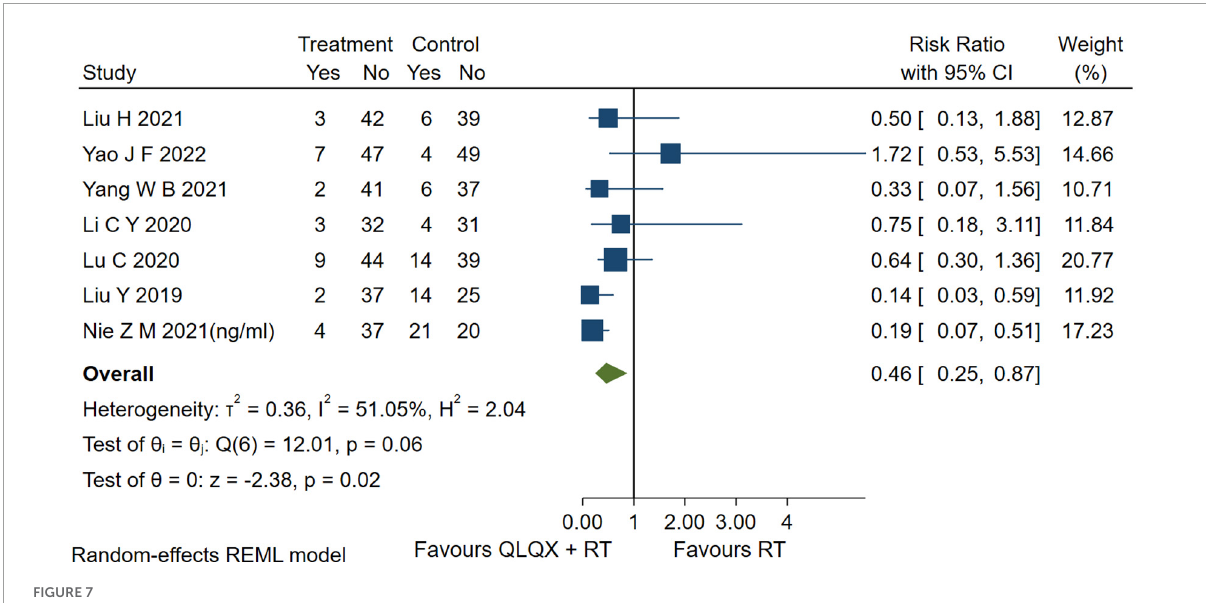
FIGURE7 Forest plot of adverse